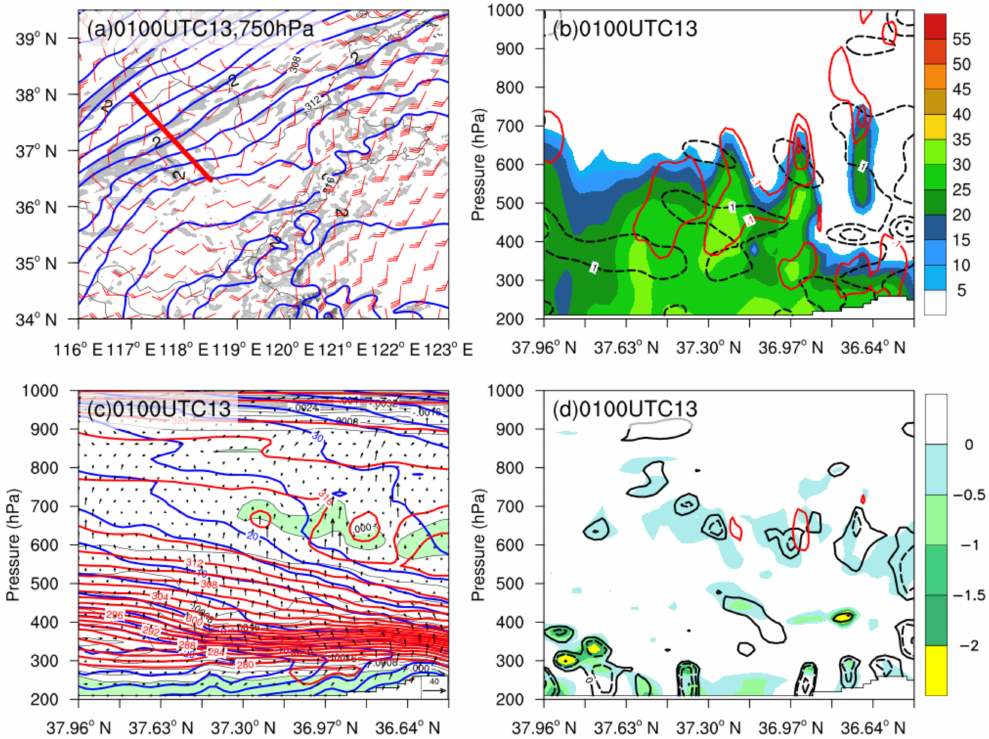
Figure 14. As in Figure 10, but for the 4 km run valid at 0100 UTC 13 February 2016, the contours are the same as Figure 10 except for saturation equivalent potential temperature in ( a ) contoured every 2 K, ascent in ( b ) contoured every 0.1 m · s − 1 and starting from 0.1 m · s − 1